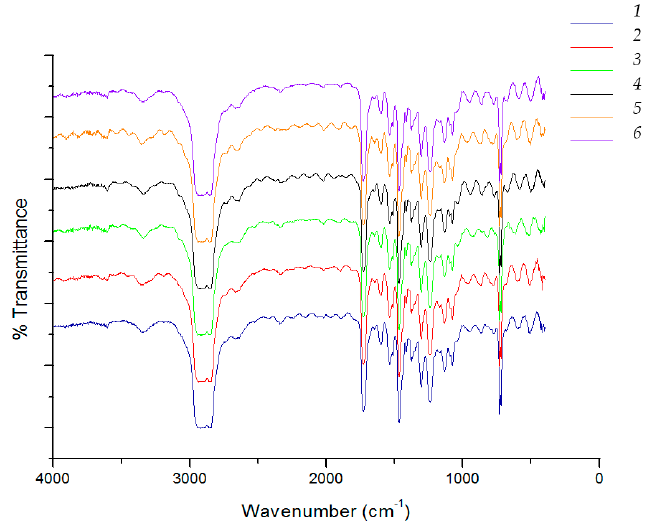
Figure 6. FT-IR spectra of PET in the recovered separated films after washing with Alcalase.